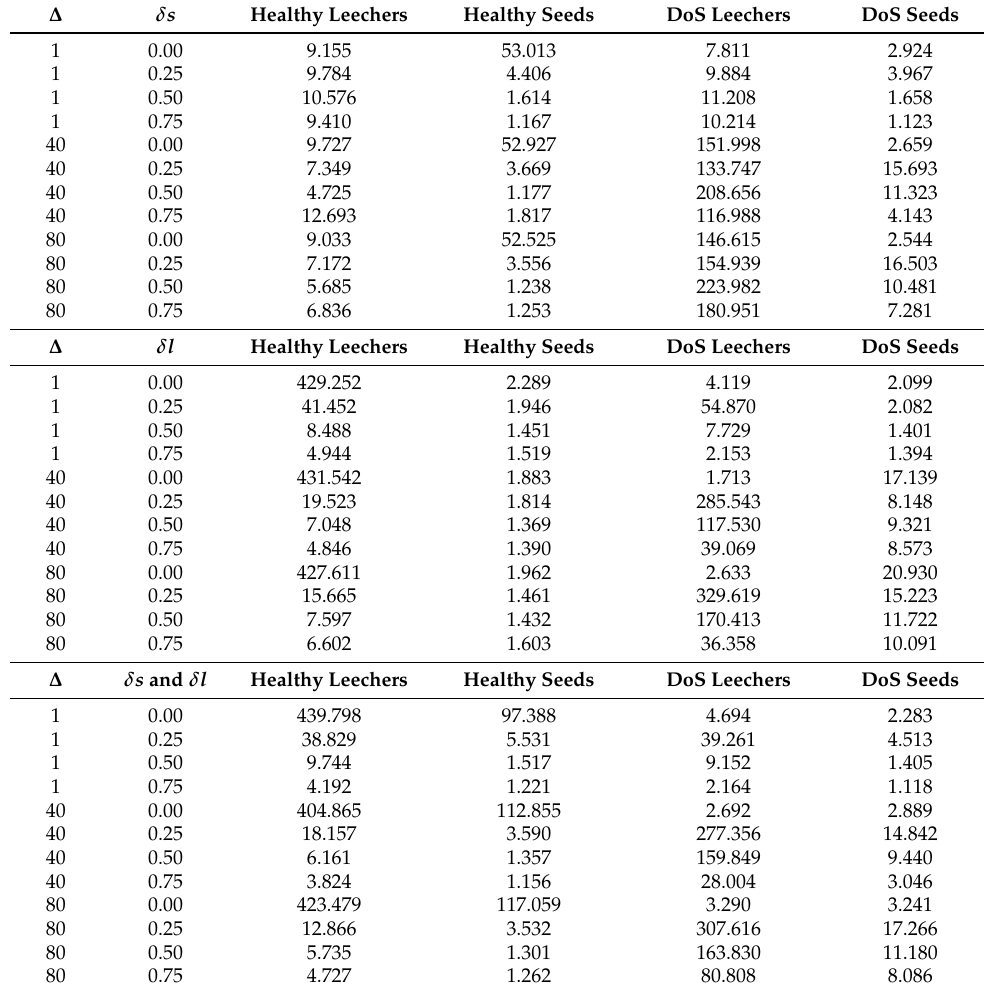
Table 6. System performance of a P2P system under a DoS attack for different attack intensity varying δ l , δ s , and ∆